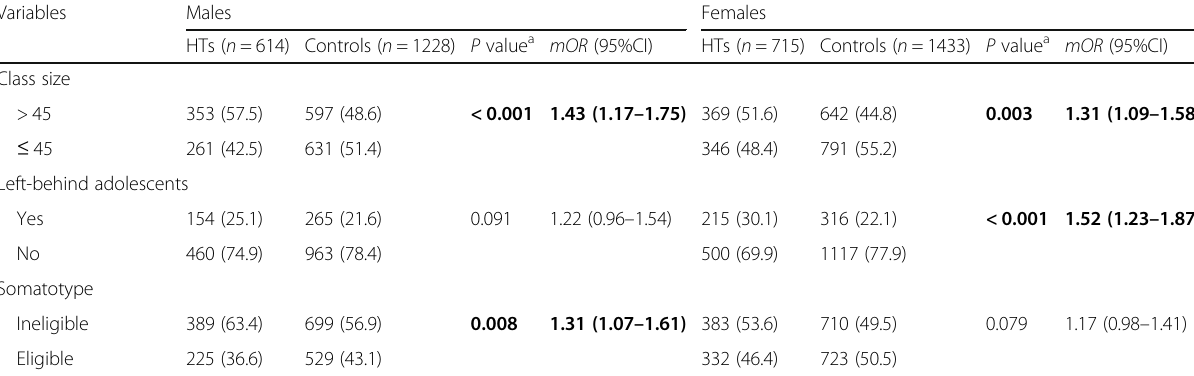
Table 2 Gender-specific for comparison of demographic characteristics between HTs and controls ( N = 3990) (Continued)